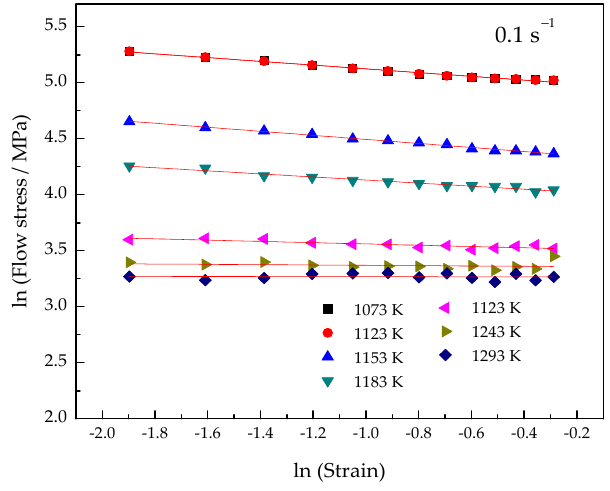
Figure 8. Relationship between ln (strain) and ln (flow stress).